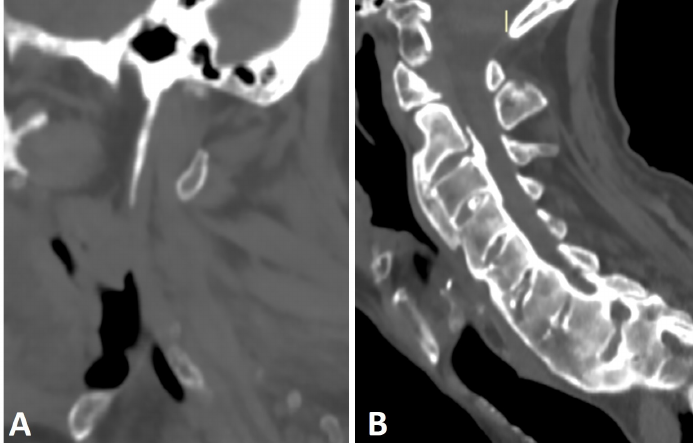
Figure 4. Sagittal CT reconstructions of the cervical spine of two patients with thoracic DISH (not shown). ( A ) The elongated styloid process results from calcification and ossification of the stylohyoid ligament. ( B ) Flowing osteophytes characteristic of DISH accompanied by OPLL.